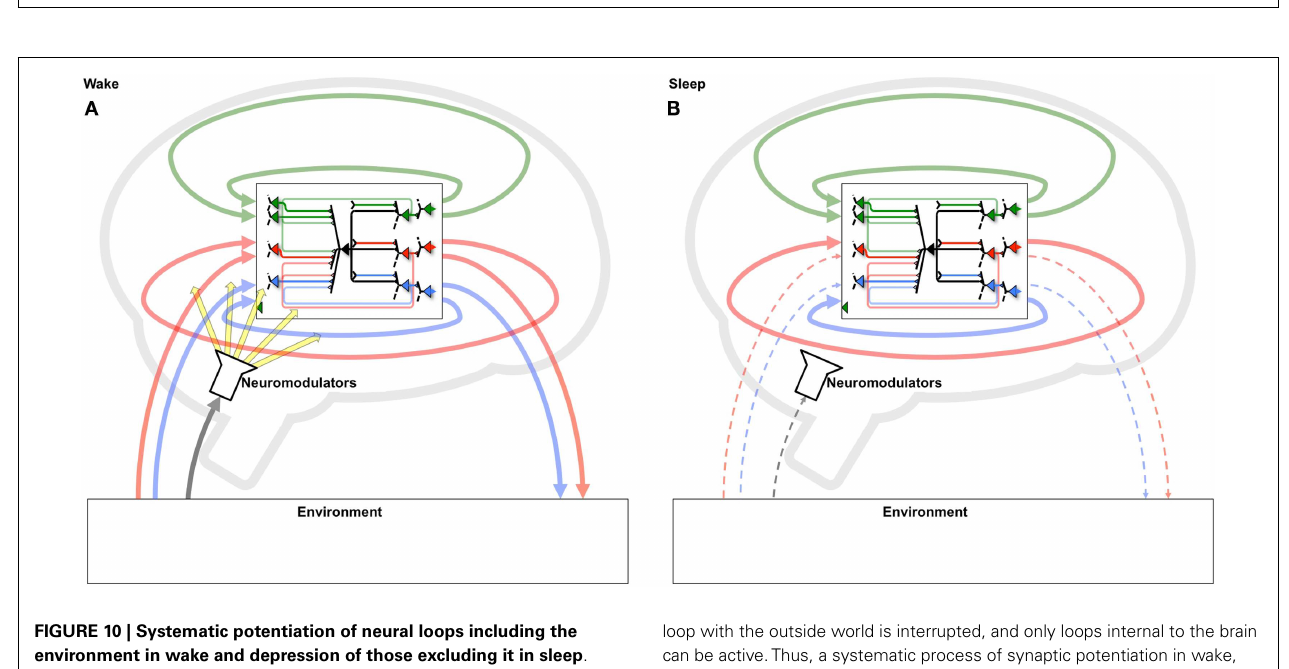
FIGURE 9 |A neuron can participate in multiple perception-action loops .Top: through its multiple dendritic domains, a single neuron can participate in multiple perception-action loops. As shown in the figure, the black neuron is part of three different cliques, shown in green, red, and blue. Coincident spiking events are surrounded by gray boxes, while